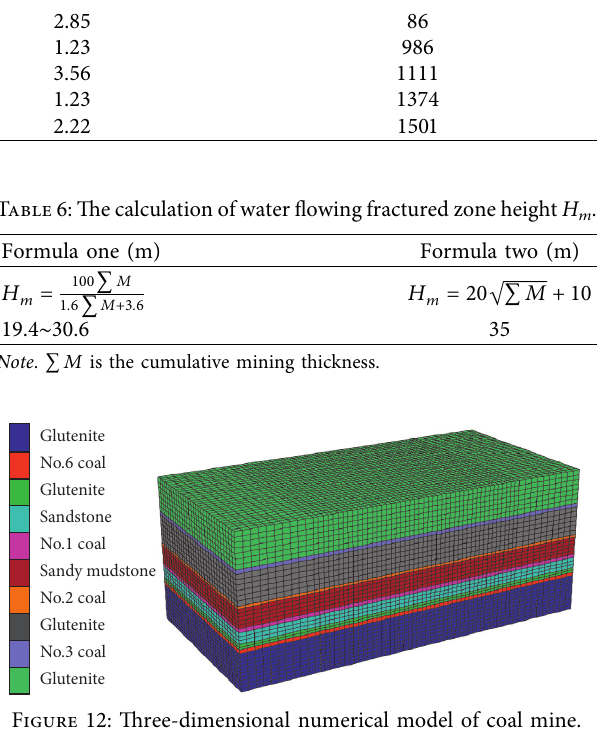
Table 5: Ultimate span, ultimate deflection, and free subsidence space of overlying strata.